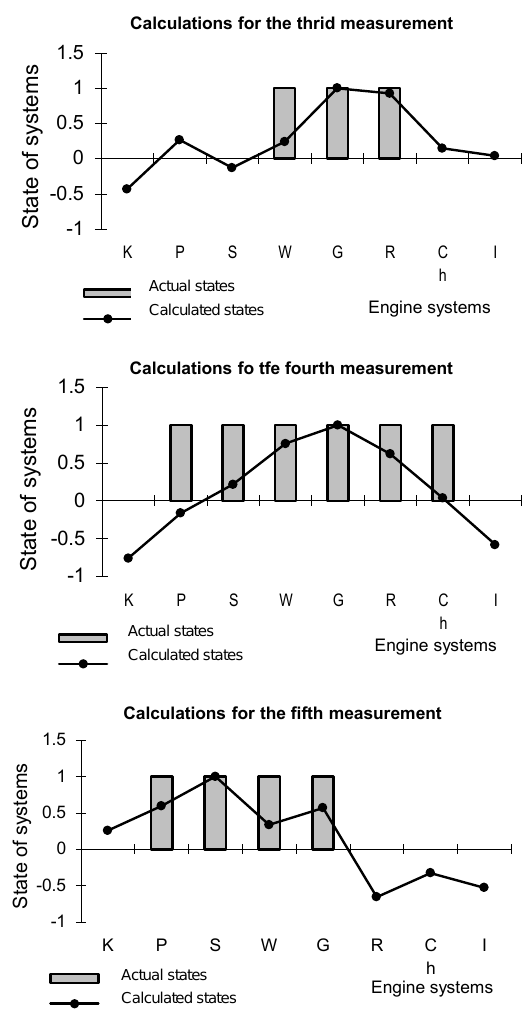
Fig. 2. The results of calculations of the engine systems states for the third measurement in operation of